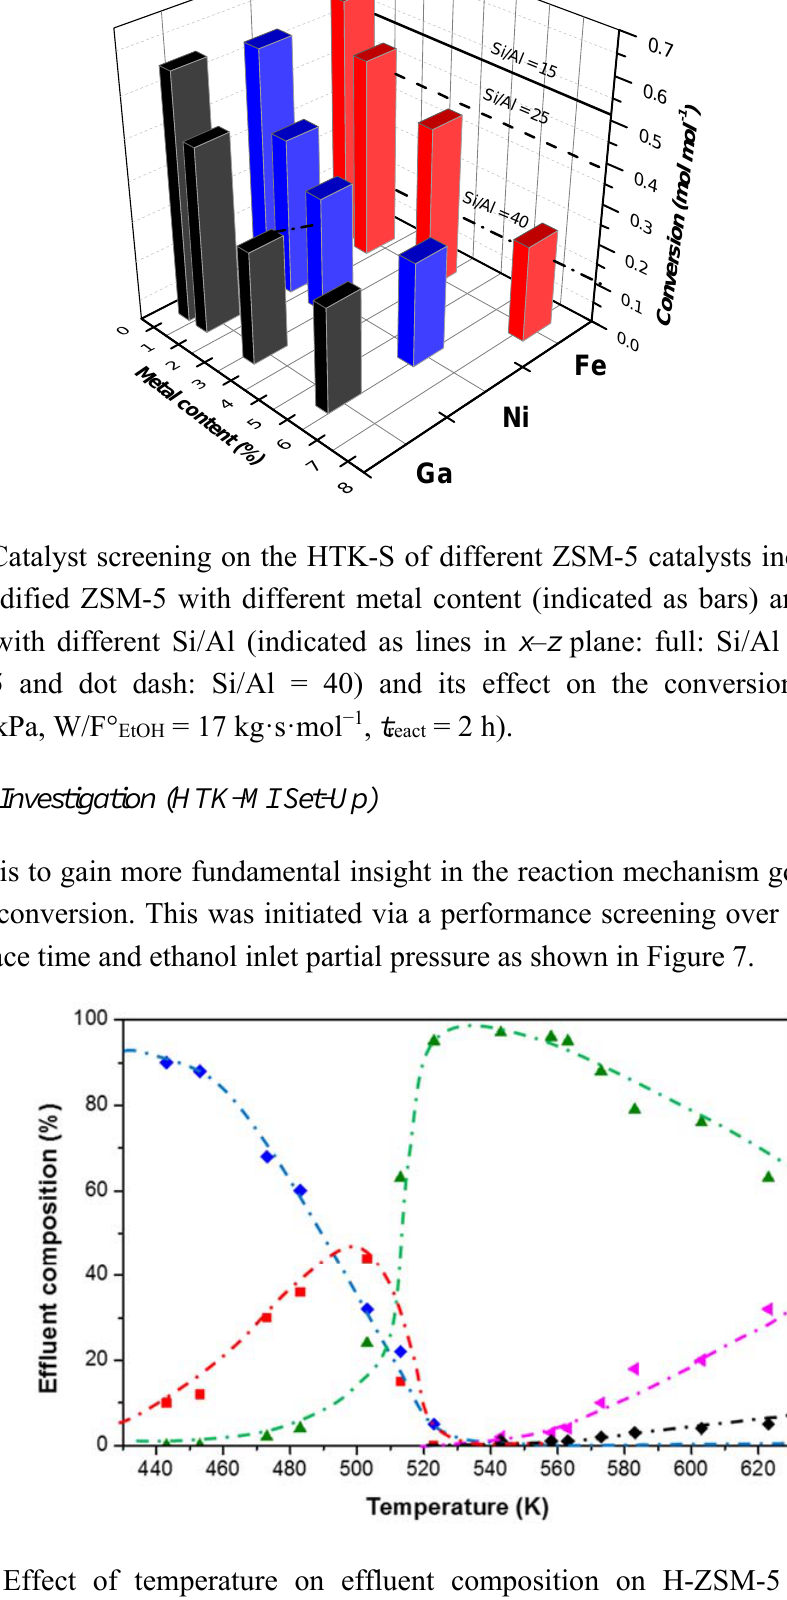
Figure 7. Effect of temperature on effluent composition on H-ZSM-5 (Si/Al = 15) (p EtOH = 20 kPa; W/F° EtOH = 8 kg·s·mol − 1 , t react = 2 h) (blue: ethanol; red: diethyl ether; green: ethene; magenta: C 3 and C 4 olefins; black: C 5+ hydrocarbons), as measured on the HTK-MI